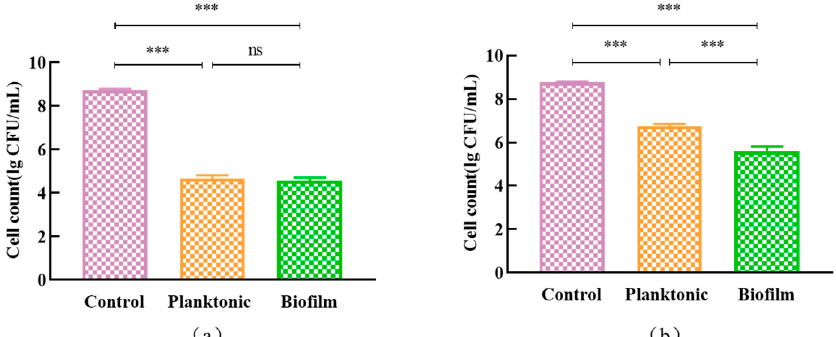
Figure 7. The inhibitory effects of planktonic and biofilm L. plantarum Y42 on the growth ( a ) and clearance ( b ) of L. monocytogenes ATCC 19115 biofilms. *** p < 0.001; ns is not significant.